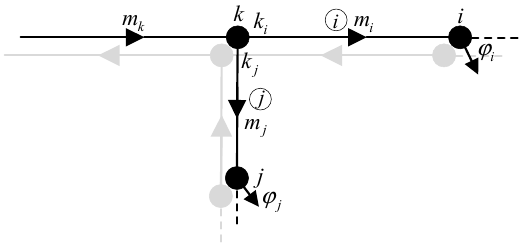
Figure A1. Detailed illustration describing the calculation of the mass flow rates correlation coefficient.